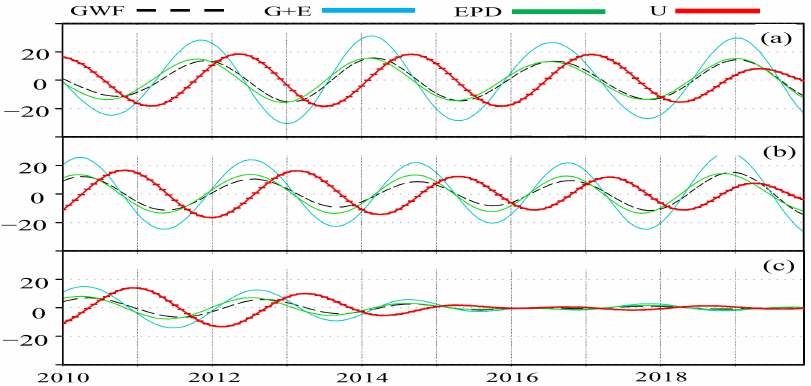
Figure 10. QBO components of zonal–mean-zonal wind (red) and parameterized gravity wave forcing (GWF, black dashed line), resolved wave forcing (EPD, light green), and combined forcing (G + E, cyan)) at 20 hPa for the ( a ) control run, perpetual runs of ( b ) January, and ( c ) April from 2010 to 2019. All of the quantities are averaged between 10 ◦ S and 10 ◦ N. Units are in ms − 1 for wind, and 10 − 2 ms − 1 day − 1 for